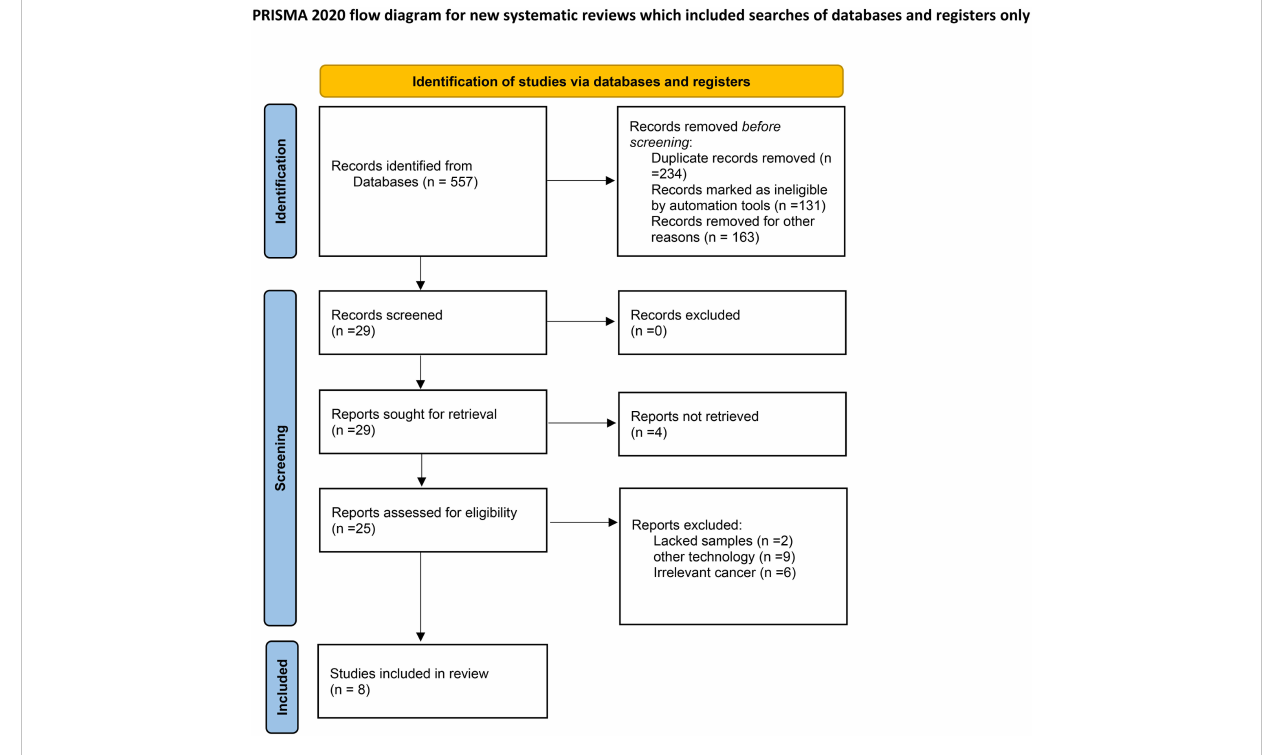
FIGURE 1 Flow diagram of included studies for this meta-analysis.